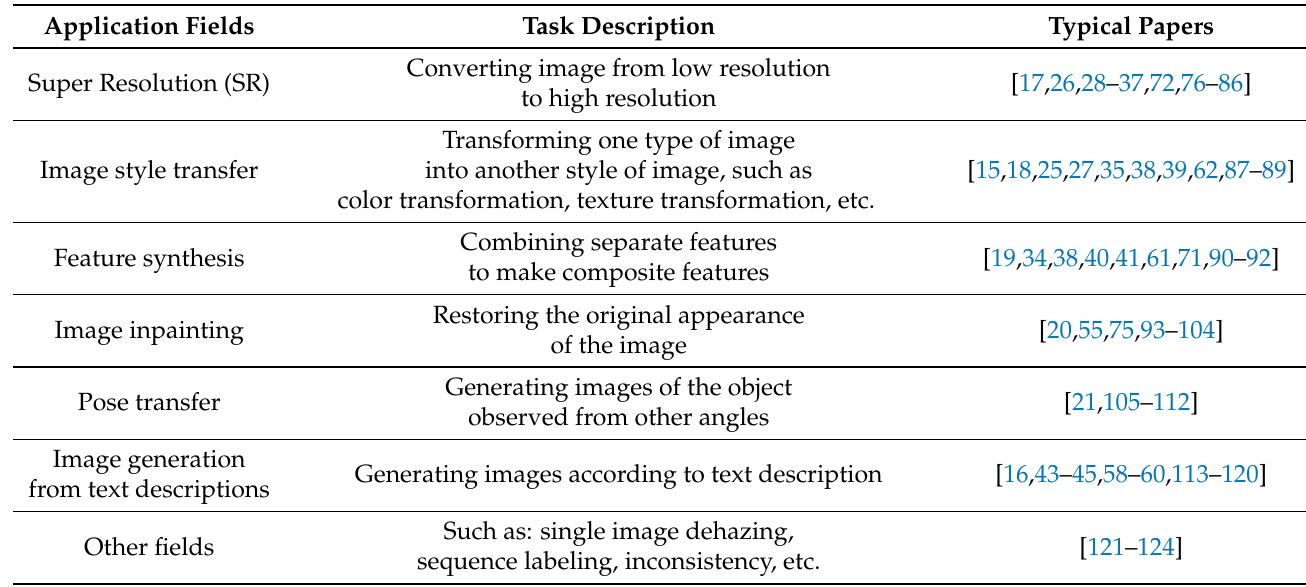
Table 5. A summary of CGANs in various application